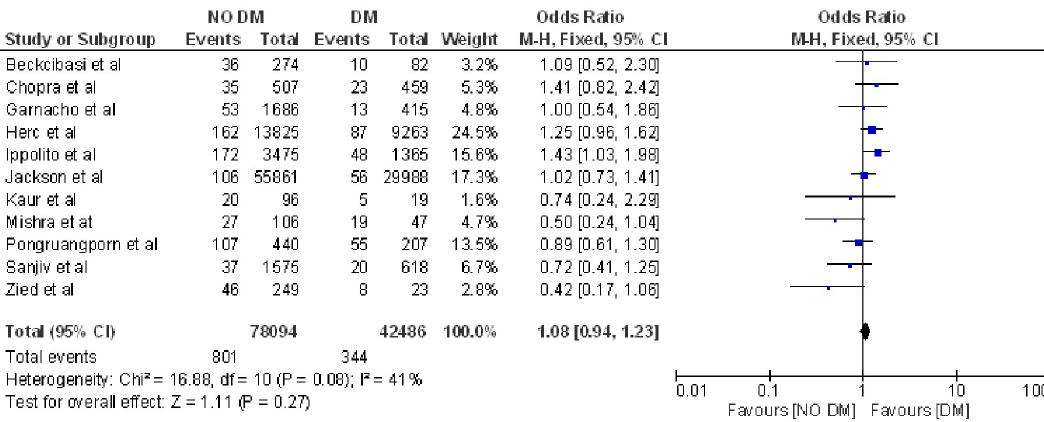
Fig 10. Forest plot of diabetes mellitus and